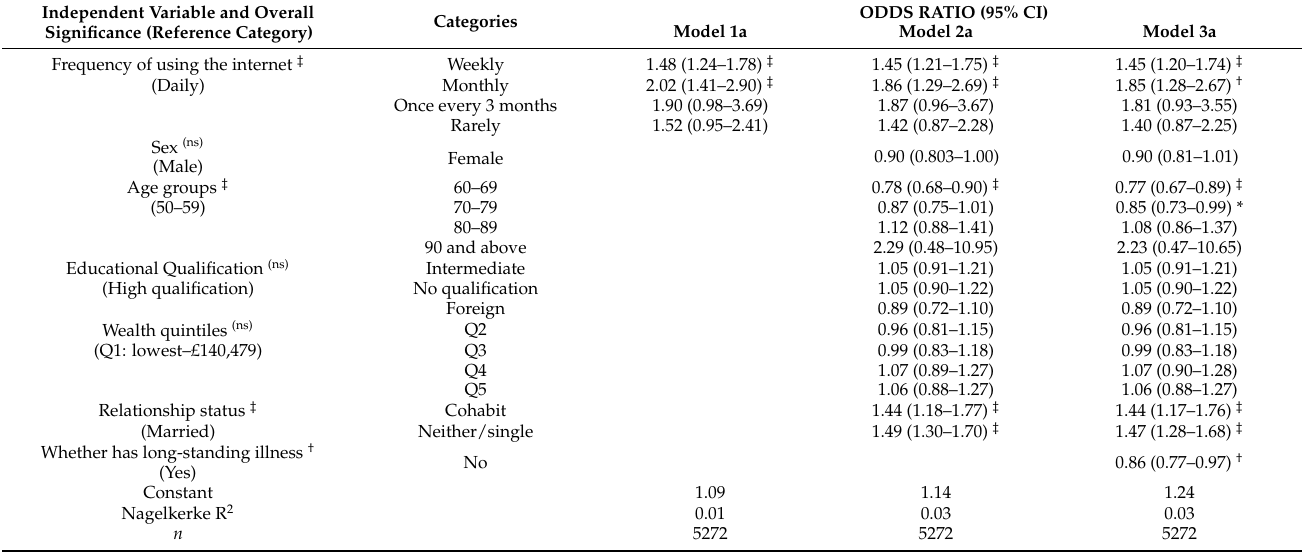
Table 4. Logistic regression results Model A.